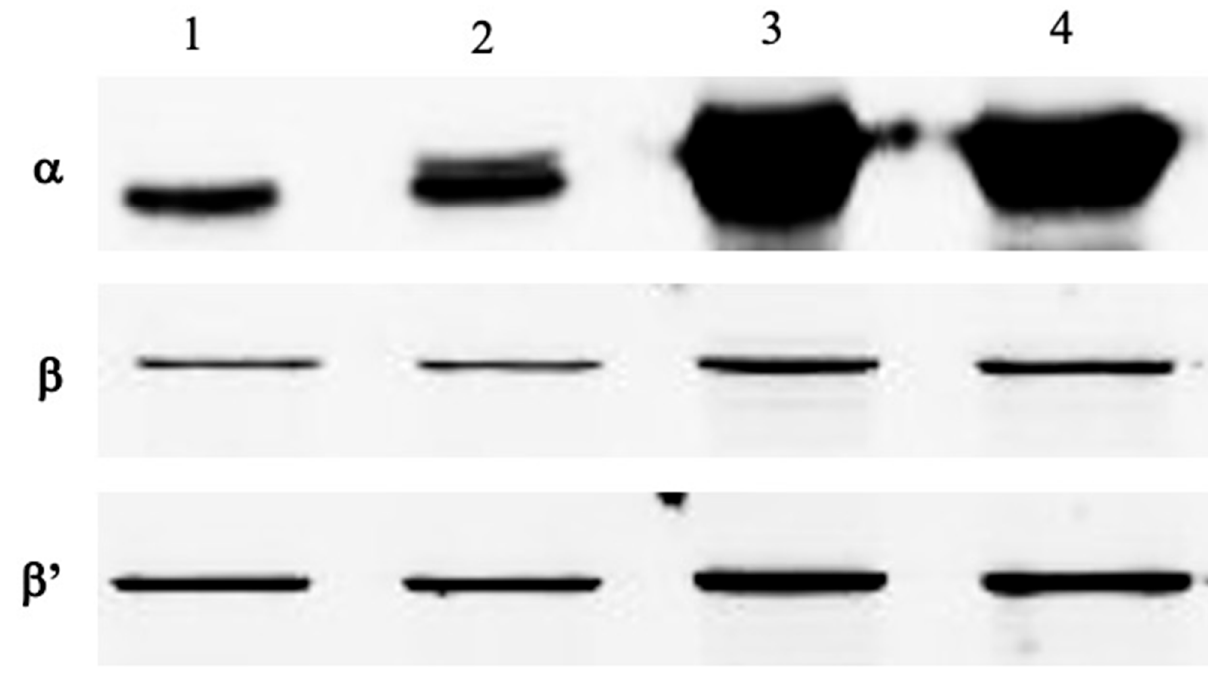
Figure 2. Western blot of RNA polymerase subunits α , β and β ’ in the supernatant of S30 extracts of cells without and with coexpression of genes rpoA , rpoB , rpoC and rpoZ . Detection of subunits was performed with the corresponding mAb. Lane 1, plasmidless E. coli BL21 Star (DE3) incubated with 1 mM IPTG; lane 2, E. coli BL21 Star (DE3) (pETDuet ‐ rpoA ‐ rpoB/pACYCDuet ‐ rpoC ‐ rpoZ) incubated without IPTG; lanes 3 and 4, E. coli BL21 Star (DE3) (pETDuet ‐ rpoA ‐